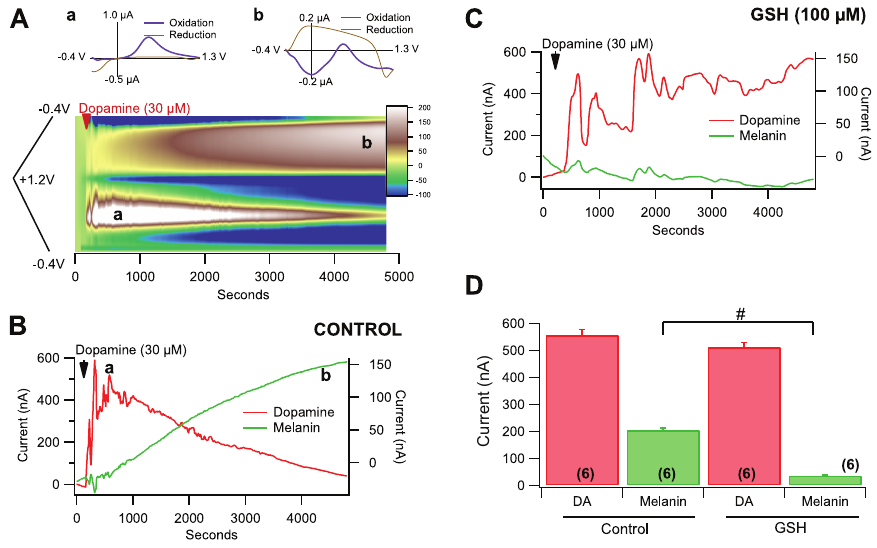
Figure 5. Fast-scan cyclic voltammetry of melanogenesis of DA in vitro. ( A ) Insets show representative cyclic voltammograms at the points indicated on the graph during equilibration (Aa) of DA (30 µ M) and following partial conversion of DA to melanin (Ab) in a closed system (3 mL of ECF). The characteristic oxidation peak at 0.5 V and reduction peak at − 0.38 V are evidence of DA (Aa). The DA redox peaks are still visible (0.5 V and − 0.38 V) more than 2 h after equilibration (Ab), but significantly reduced, indicating that DA is still in solution, but the redox signal slowly decays as the signal from melanin grows (a broad peak extending from − 0.02 V and a sharper peak at − 0.4 V). The colorplot below shows currents on the color z -axis for cyclic voltammograms over time at 1 Hz sampling rate. The voltammograms in Aa and Ab were taken at the times a,b indicated on the plot, demonstrating the peak and fall of DA and the progressive emergence of melanin. ( B ) This graph shows the current over time for DA vs. melanin in the same example shown in A. ( C ) In this representative example, 100 µ M GSH not only blocked the formation of melanin by 30 µ M DA but the decay in DA over time. ( D ) Cumulative comparison of spontaneous melanogenesis as measured by FSCV. GSH significantly reduced DA melanogenesis. Significance marker # denotes p < 0.0001. Data is presented as mean ±